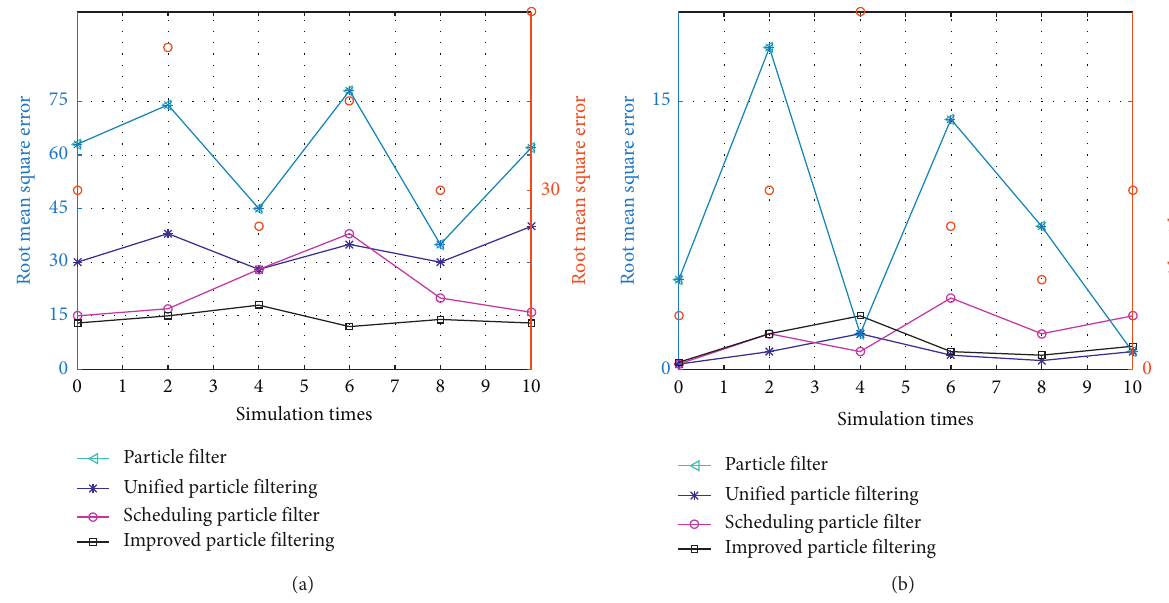
Figure 5: Root mean square error of model parameter identification value. (a) k 0. (b) n .